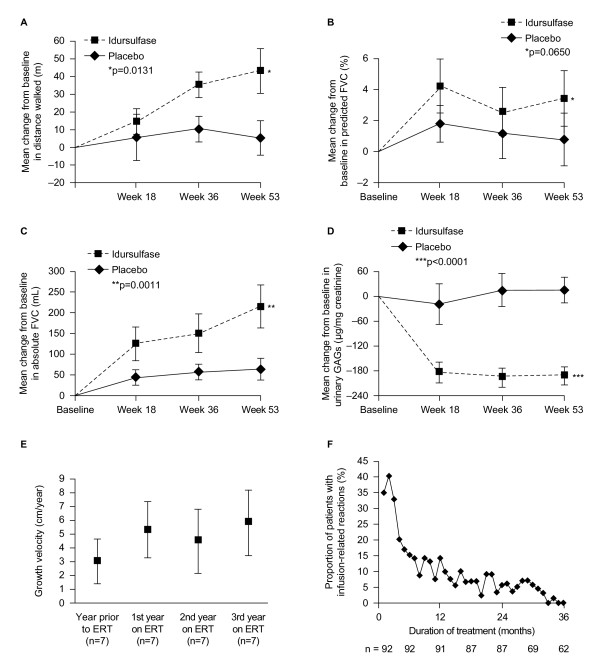
Clinical effects of enzyme replacement therapy (ERT) with idursulfase (0.5 mg/kg weekly) or placebo in patients with mucopolysaccharidosis type II (MPS II). (a) Mean (± SE) change from baseline in distance walked in 6-minute walk test; (b) mean (± SE) change from baseline in percentage of predicted forced vital capacity; (c) mean (± SE) change from baseline in absolute forced vital capacity; (d) mean (± SE) change from baseline in concentration of urine glycosaminoglycans; (e) mean (± SD) growth velocity before and during enzyme replacement therapy; (f) incidence of infusion reactions during treatment with idursulfase. Absolute forced vital capacity is a better measure of respiratory function than percentage of predicted forced vital capacity, as the latter assumes both normal growth and height, which does not apply to patients with MPS II. (a-d) adapted from [34] with permission; (e) reproduced from [37] with kind permission from Springer Science & Business Media; (f) reproduced from [35] with permission. *p = 0.0131; **p = 0.011; ***p < 0.0001, compared with placebo based on analysis of covariance. SD = standard deviation. SE = standard error. ANCOVA = analysis of covariance. FVC = forced vital capacity. ERT = enzyme replacement therapy.